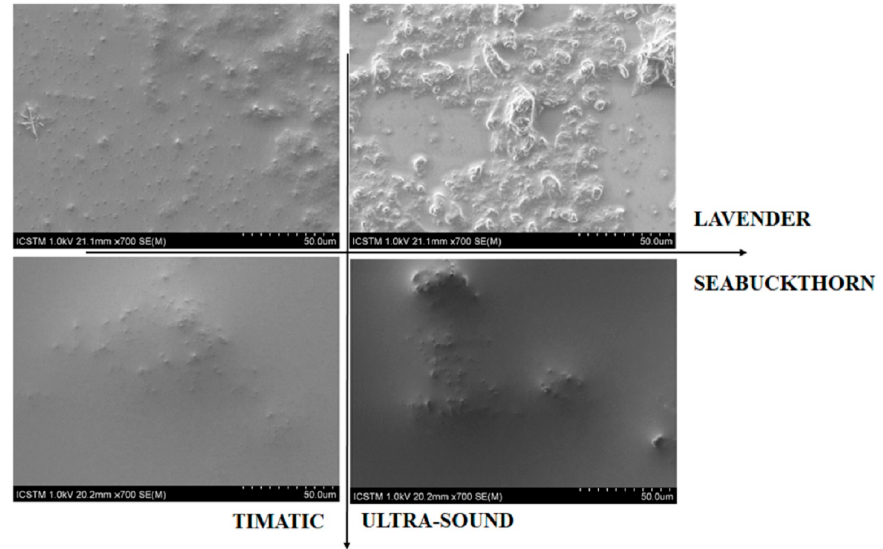
Figure 4. Scanning electron micrographs of 1.Lf Aa T and 1.Hf Aa T on the left and 1.Lf Aa US and 1.Hf Aa US on the right.